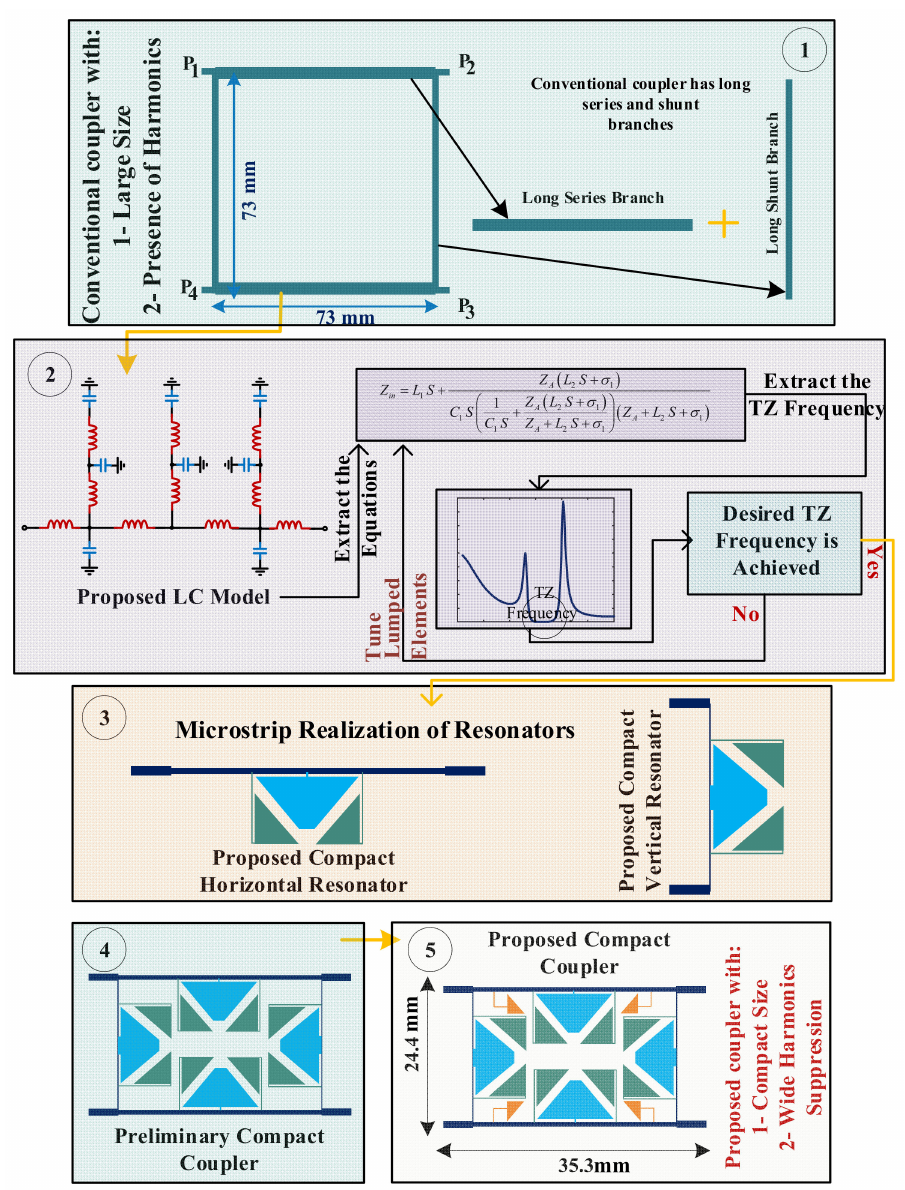
Figure 2. Design procedure of the proposed coupler. In this figure, the design steps of the proposed circuit are explained in 5